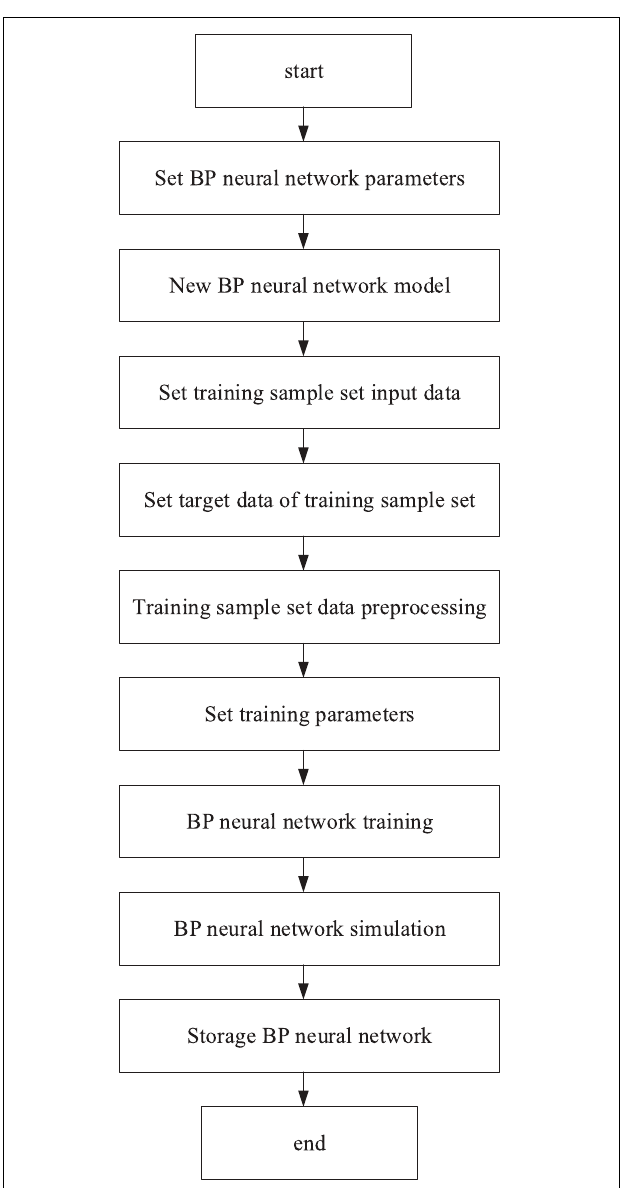
FIGURE 7 | Establishment process of the BPNN